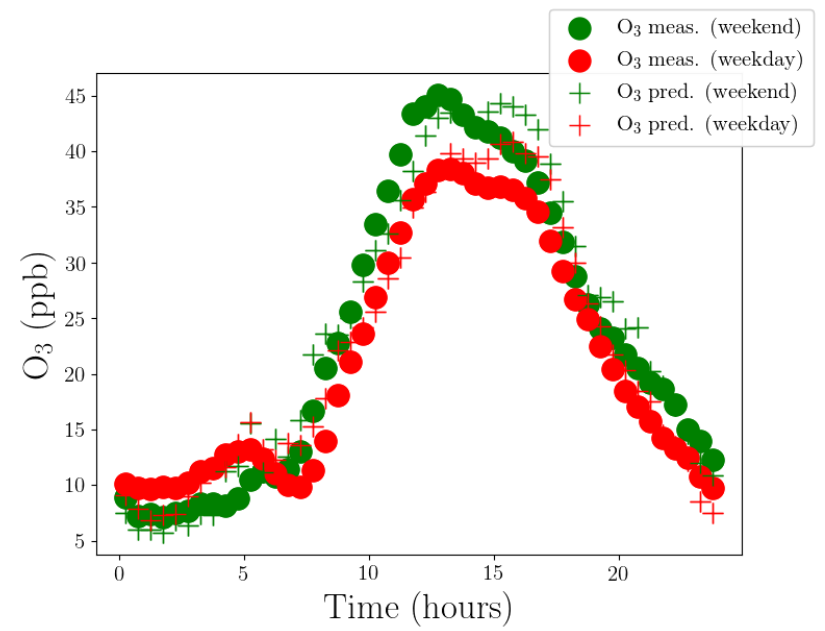
Figure 11. The average of the measurement and estimation of Ozone concentration from two different models on weekday and